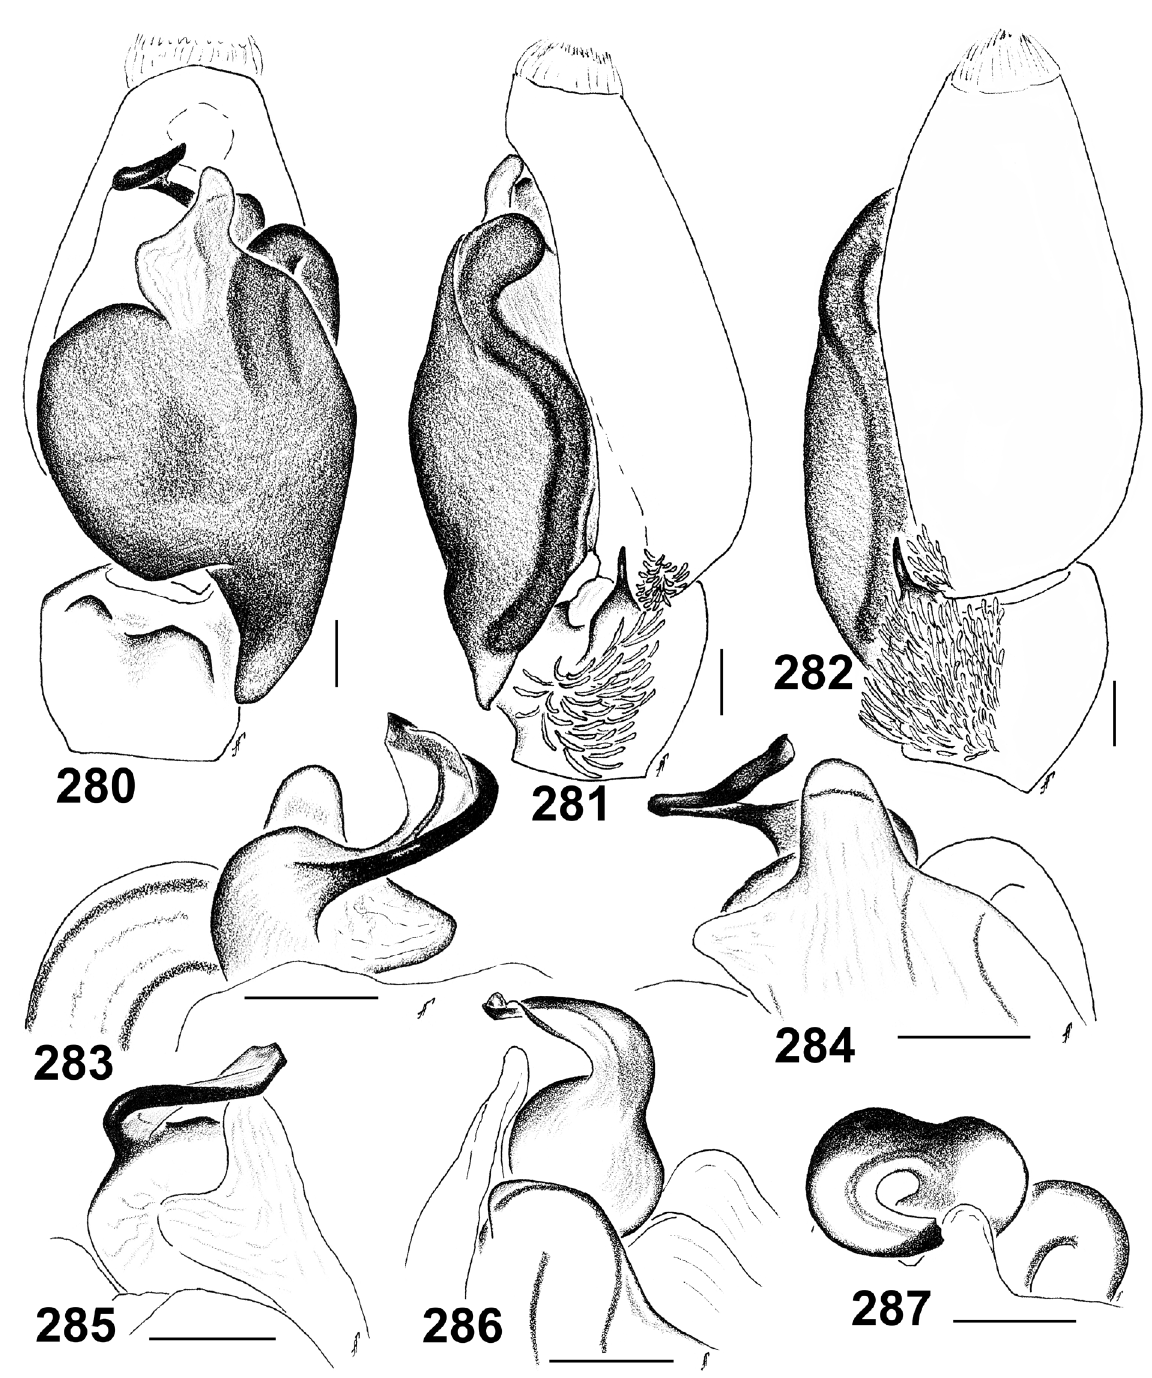
Figs 280–287. Stenaelurillus jocquei sp. nov., holotype (280–283) and paratype (284–287), ♂♂ from Cameroon (Faro GR), light form. 280–282 . Male palp. 280 . Ventral view. 281 . Retrolateral view. 282 . Dorso-retrolateral view. 283–287 . Embolic division. 283 . Dorsal view. 284 . Ventral view. 285 . Median view. 286 . Retrolateral view. 287 . Apical view. Scale bars: